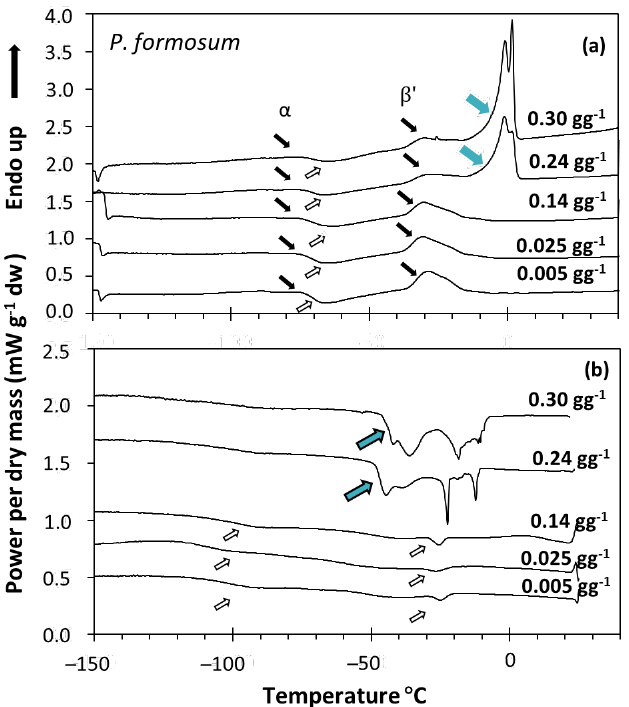
Figure 2. DSC melting ( a ) and cooling ( b ) scans of Polytrichum formosum acc. 1 spores containing the indicated water content. Samples were scanned at 10 °C min − 1 from 25 to − 150 °C and then from - 150 to 40 °C. Lipid melting transitions are expressed using black arrows for the melting events and white arrows for the crystallization events (as in Figure 1). When water content increased, other peaks appeared (blue arrows), increasing the enthalpy of the main event ( ∆ Hm) and occurring at 0 °C in the melting scans ( a ). These peaks were attributed to water melting ( a ), and water + lipid crystallization ( b ).